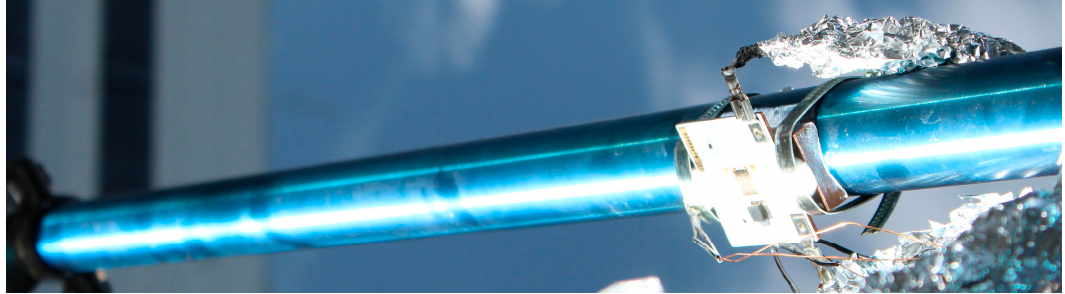
Figure 17. The temperatures (continuous lines) and the power of the solar cell (maximum power point (MPP); dashed line) shown over time. The tracking system is switched off. As the sun moves, the line focus of the concentrated sunlight passes over the solar cell and reaches the cell center at 15:02:30. The sinusoidal course of the power output is due to the movement of the sun, the data were not filtered.